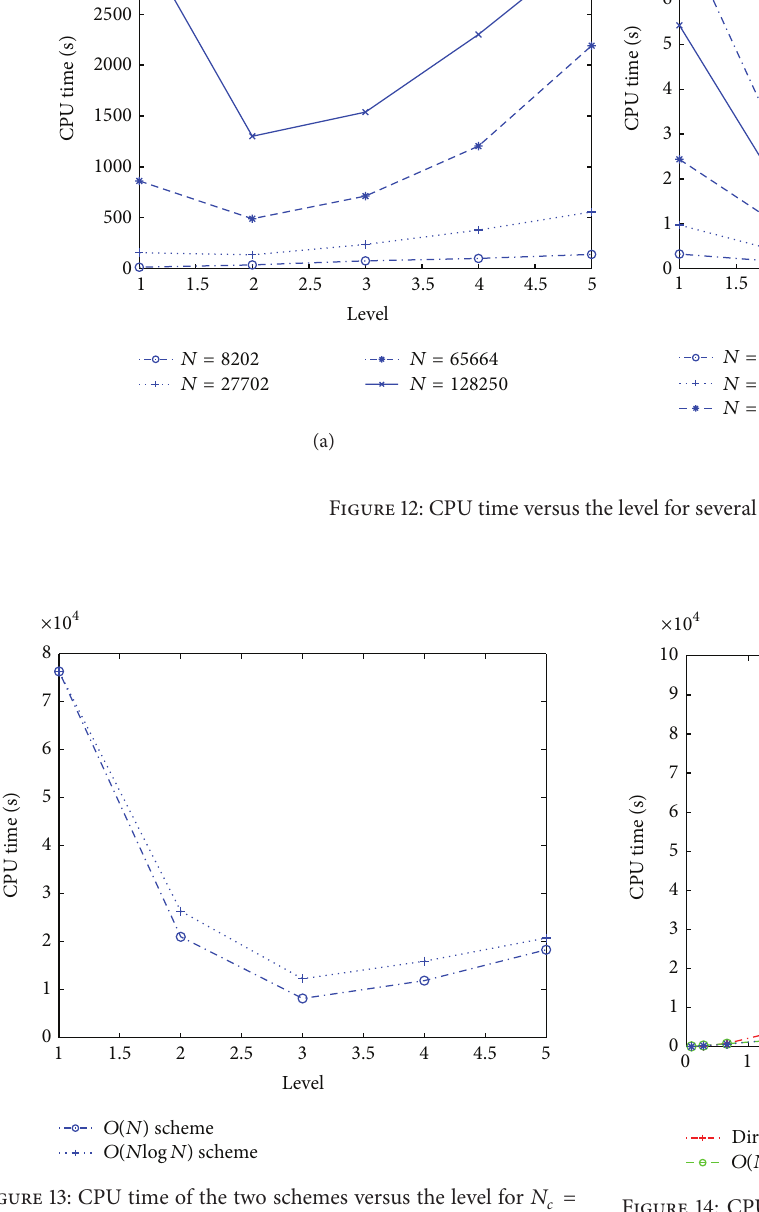
Figure 14: CPU time of the direct calculus and the two schemes 𝑂(𝑁 log 𝑁) and 𝑂(𝑁) versus the collocation points 𝑁